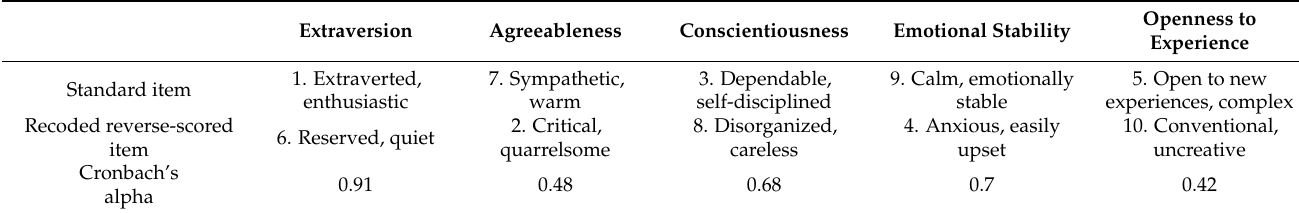
Table 5. Internal consistency of standard items and the recoded reverse-scored items.